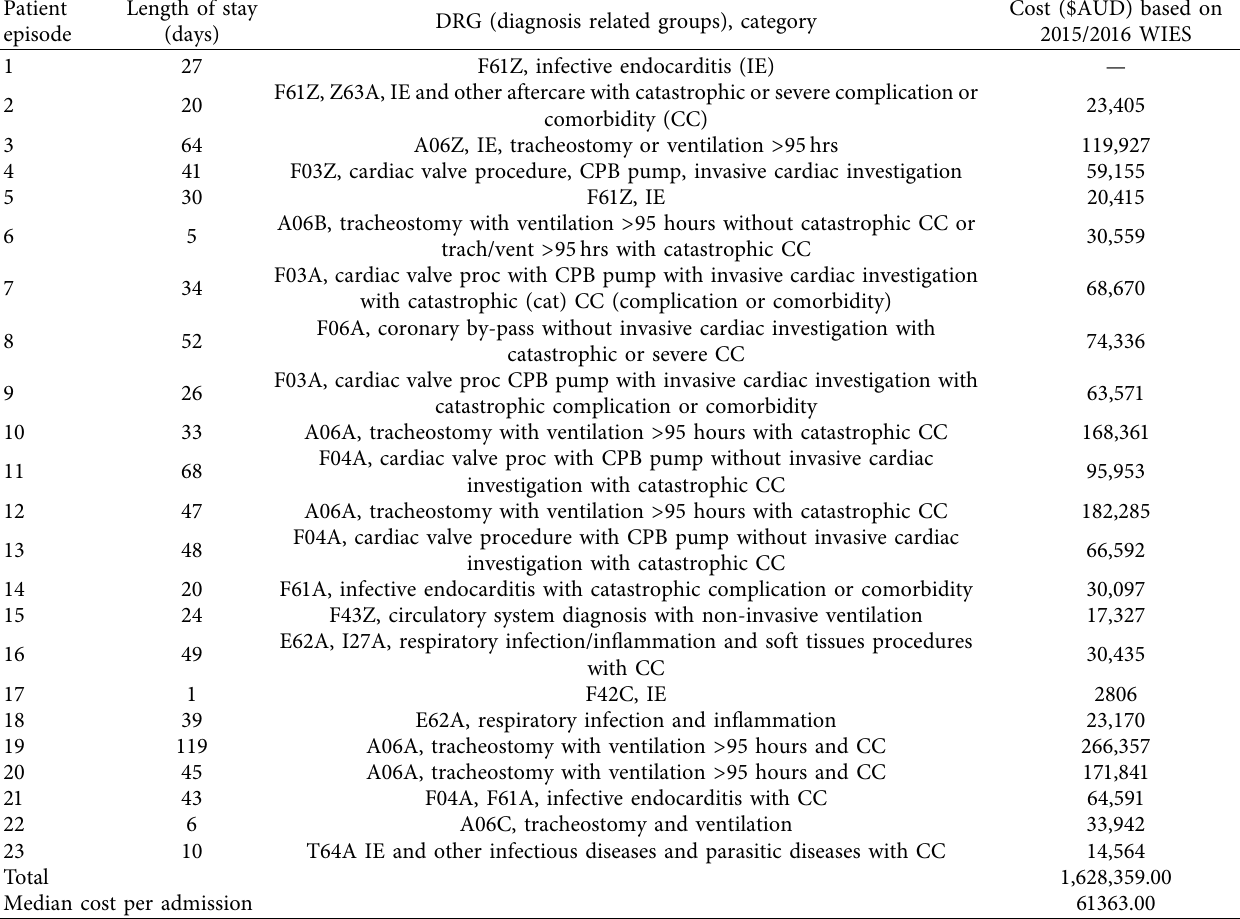
Table 1: Cost per admission as derived from DRG (diagnosis related group) and WIES (weighted inlier equivalent separation) calculations. Patient